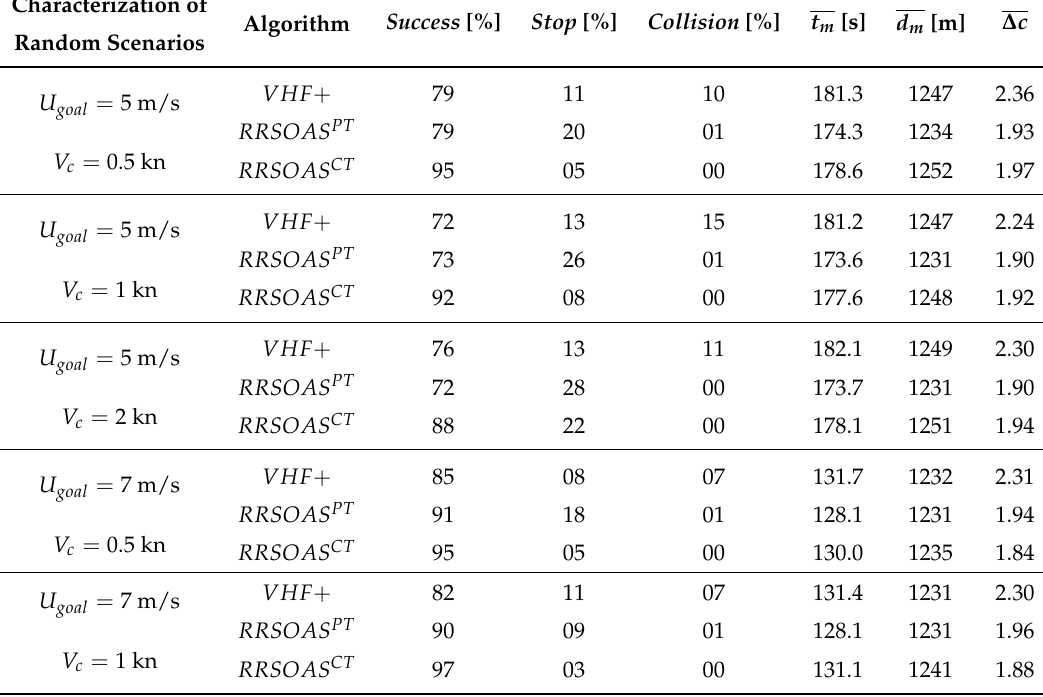
Table 4. Indicators obtained by the reactive algorithms for each sample of one-hundred random scenarios parameterized in terms of U goal and V c